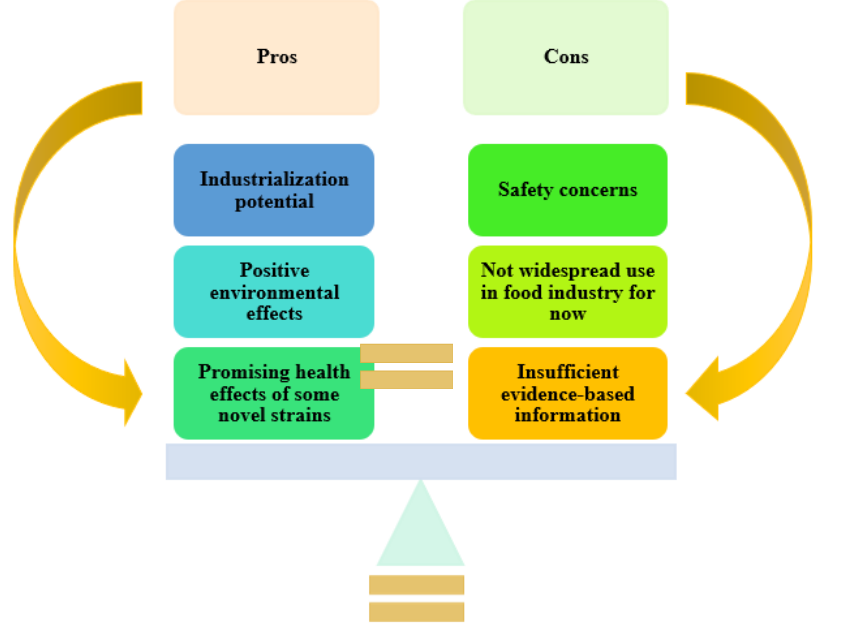
Figure 6. Advantages and disadvantages of novel microorganisms compared to traditional ferment- ative